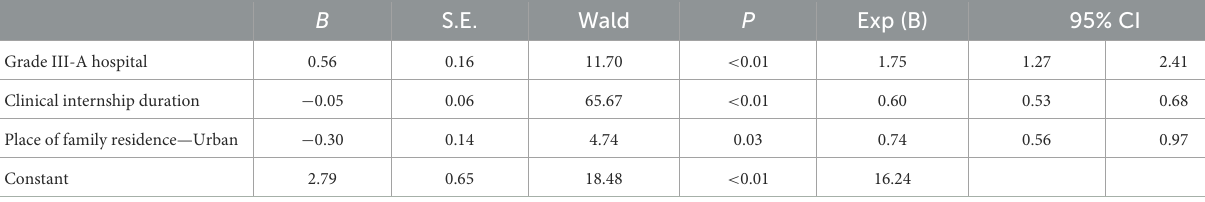
TABLE 5 Factors influencing psychological WPV among nursing interns ( N = 1,095).